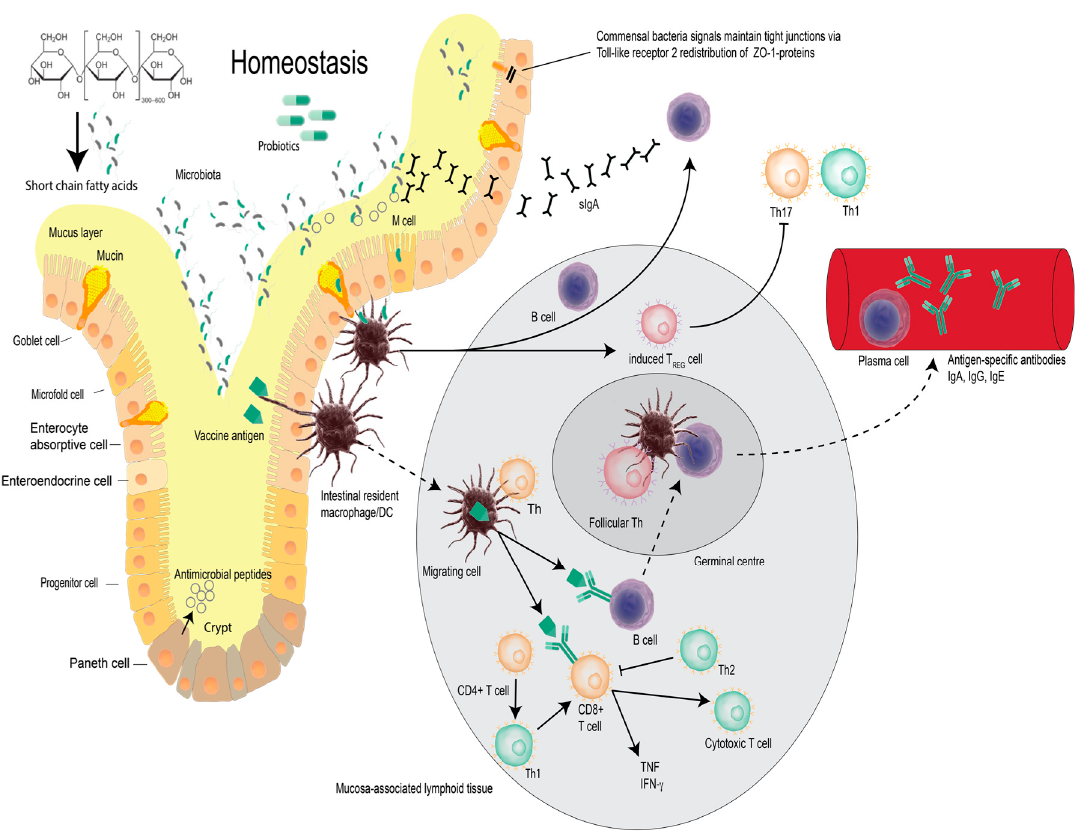
Figure 1. Vaccine, epithelial barrier function and intestinal homeostasis. Intestinal immunological homeostasis is maintained by a complex interplay of the intestinal epithelial and localised immune cells. Antigen presenting macrophages/dendritic cells in the mucosa and associated lymphoid tissue, Peyer’s patches, mesenteric lymph nodes and lymphoid follicles co-ordinate immunological responses to maintain local homeostasis. Intestinal homeostasis supports the vaccine-induced production of antigen-specific antibodies via the presentation of vaccine antigen by migrating dendritic cells to B cells in the mucosa associated lymphoid tissue. Vaccine antigens also stimulate naïve CD4 + and CD8 + T cells to differentiate into cytotoxic T cells and to release antimicrobial cytokines. This figure